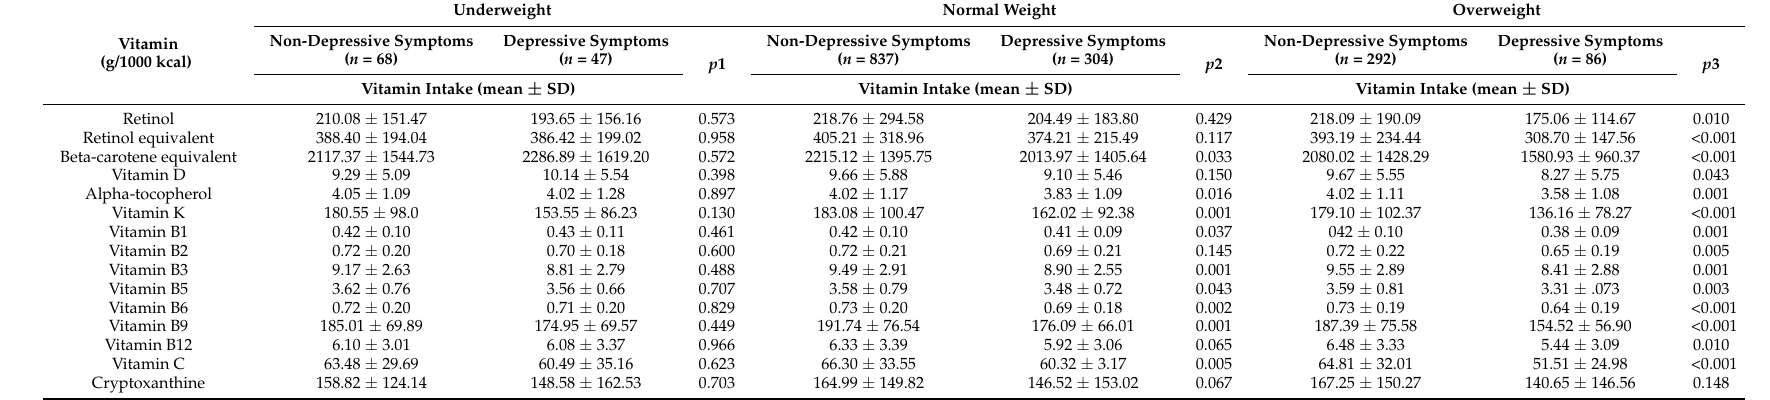
Table 4. Differences in vitamin intake between the groups with and without depressive symptoms by